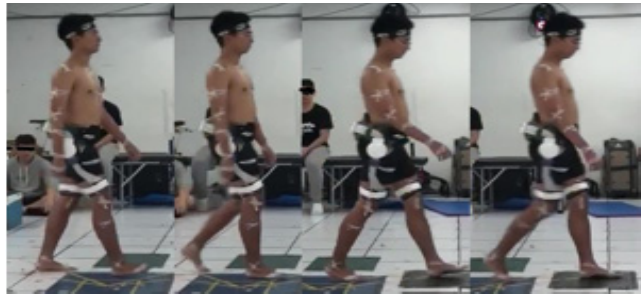
Figure 22. Testing process for power assistance of gait rehabilitation.